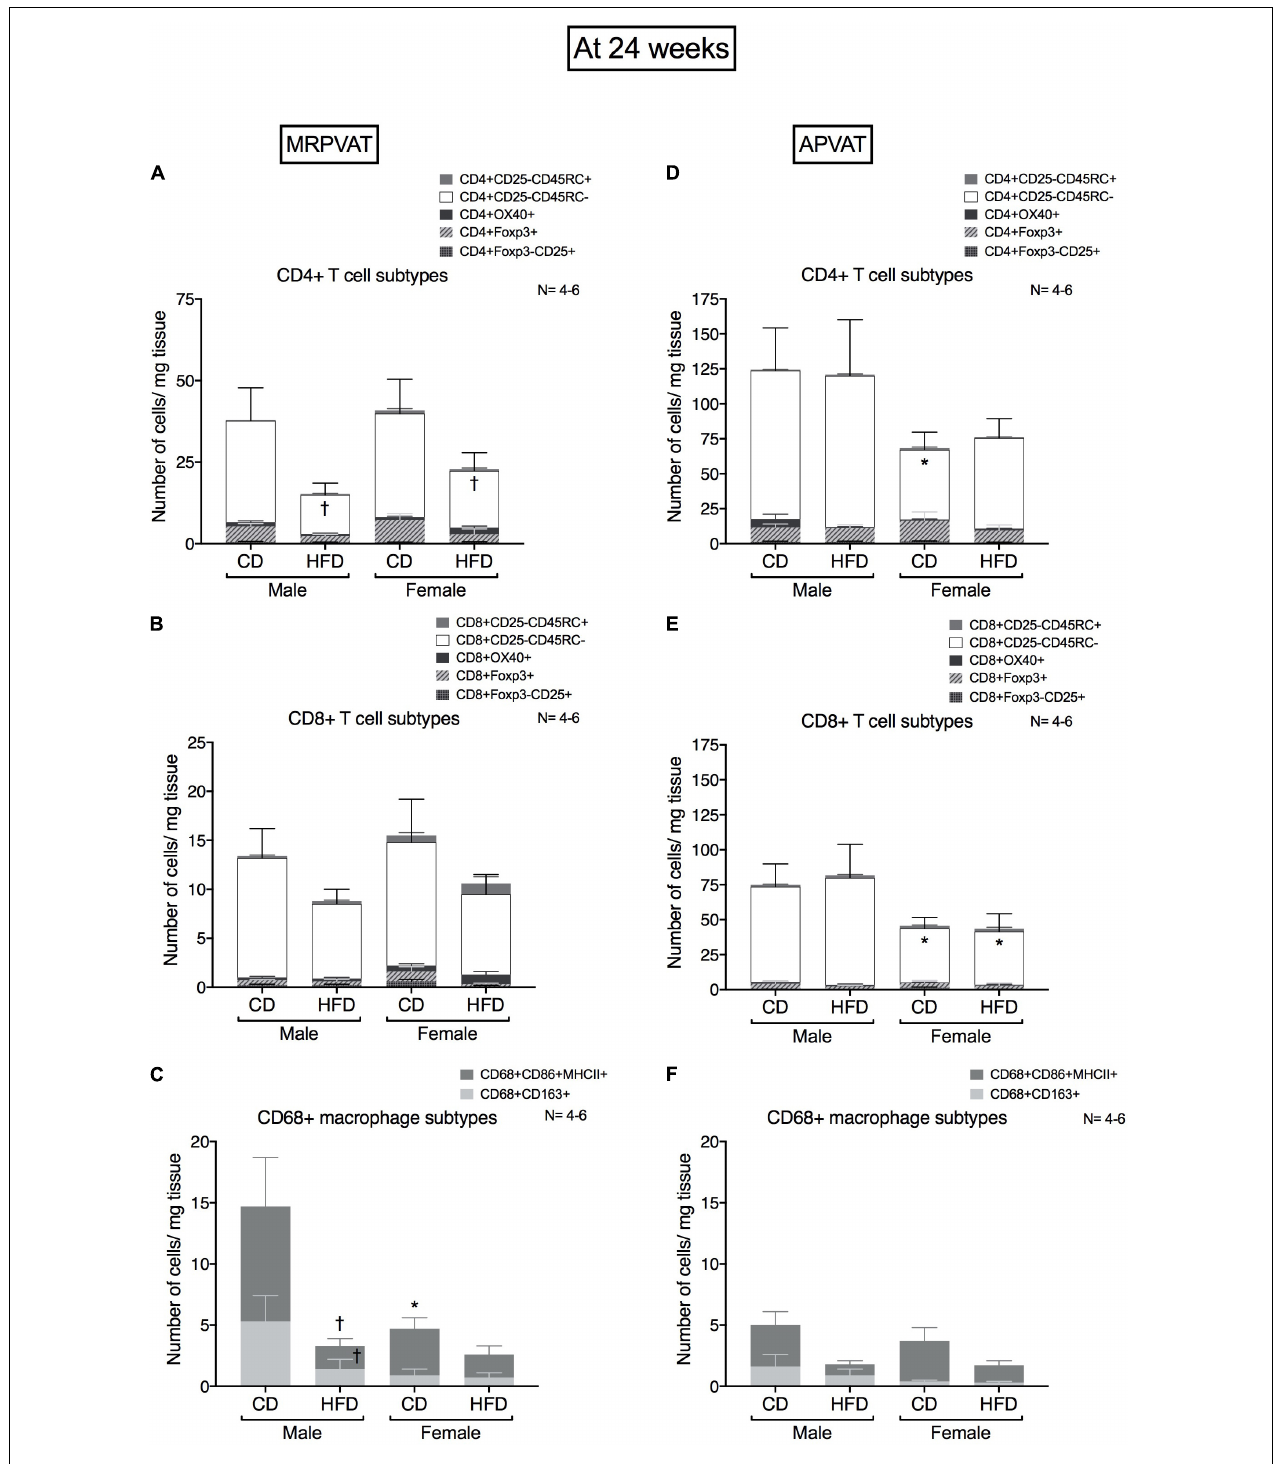
FIGURE 5 | Sex-differences in immune cells diminish with the progression of hypertension after 24 weeks on diet. Subtypes of CD4 + , CD8 + T cells and CD68 + macrophages in MRPVAT and APVAT of both sexes at 24 weeks on diet (hypertensive with HFD) were quantified by flow cytometry. Subtypes of CD4 + T cells (A,D) , CD8 + T cells: cells (B,E) , and CD68 + macrophages (C,F) were measured. Bars represent means ± SEM for the absolute cell counts of each immune cell type, normalized to tissue weight (in milligram). Number of animals is indicated by N. A P < 0.05 by two-way ANOVA with Tukey’s test for multiple comparison, was considered statistically significant. * and † inside/outside the stacks in the graph represent a significant difference in the specific stack of immune cells/sum total of immune cells between the sexes within each diet and between the diets within each sex respectively.